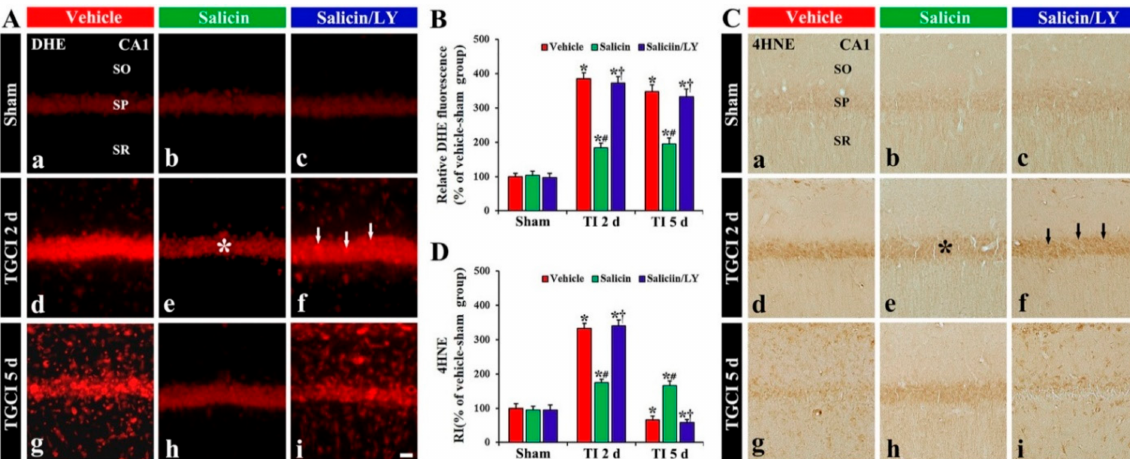
Figure 4. ( A , C ) DHE fluorescence ( A ) and 4HNE immunohistochemistry ( C ) in CA1 of the vehicle-treated (left columns), salicin-treated (middle columns), and salicin/LY-treated (right columns) groups at sham ( Aa – Ac , Ca – Cc ), 2 days ( Ad – Af , Cd – Cf ), and 5 days ( Ag – Ai , Cg – Ci ) after TI. In the salicin-TI group, DHE fluorescence and 4HNE immunoreactivity in pyramidal cells (asterisks) are significantly lower than that in the vehicle-TI group. However, in the salicin/LY-TI group, DHE fluorescence (white arrows) and 4HNE immunoreactivity (black arrows) are significantly higher than that in the salicin-TI group. Scale bar = 50 µ m. ( B , D ) RI of DHE fluorescence ( B ) and 4HNE ( D ) in pyramidal cells. The bars indicate the means ± SEM ( n = 5 at each time, * p < 0.05 vs. each sham group, # p < 0.05 vs. vehicle-TI group, † p < 0.05 vs. salicin-TI group; the vehicle-sham group was regarded as control